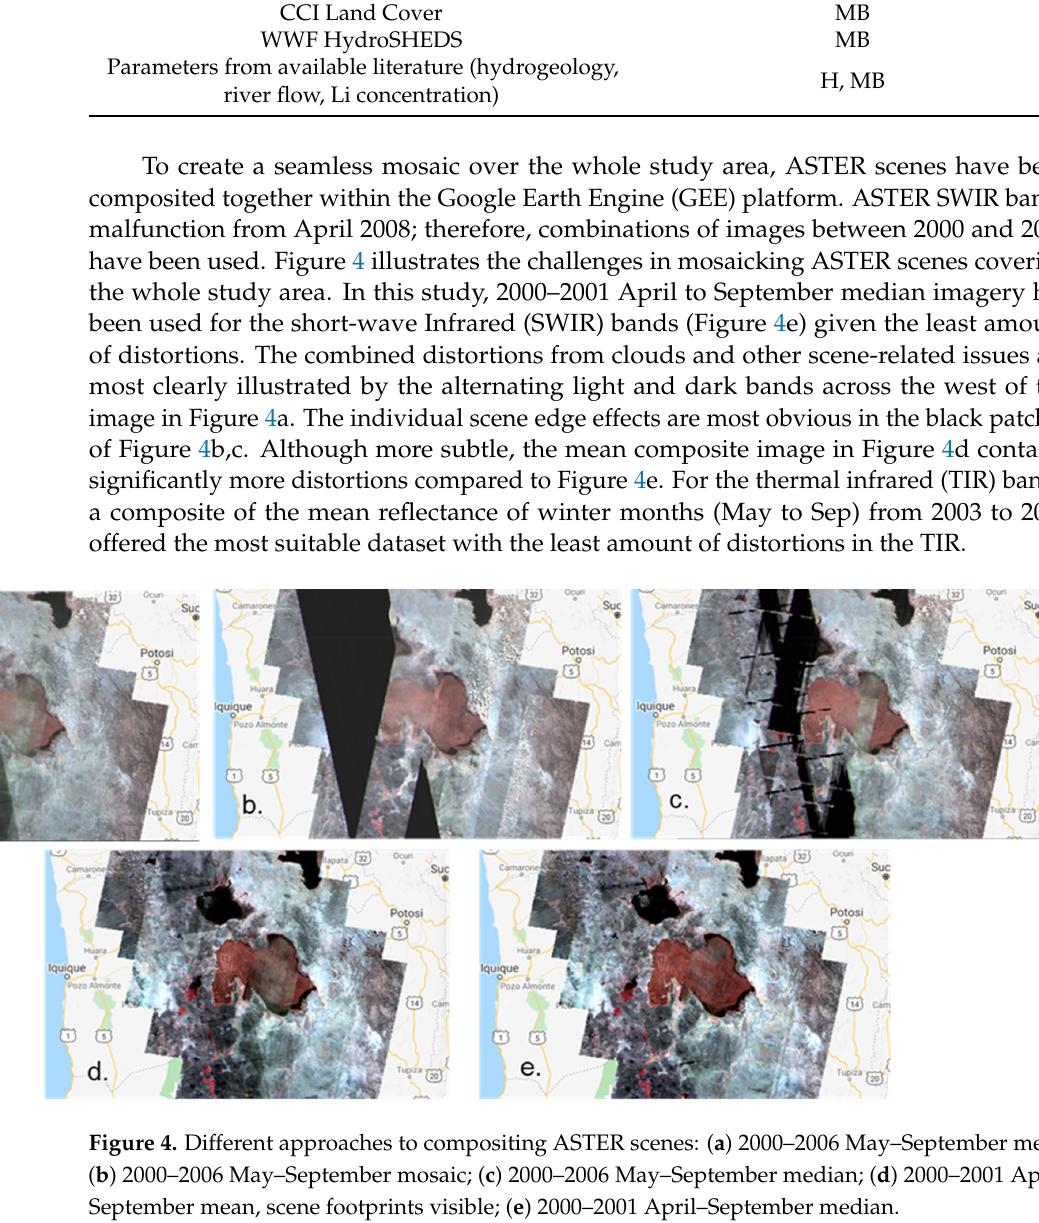
USGS 1:500 k geological map